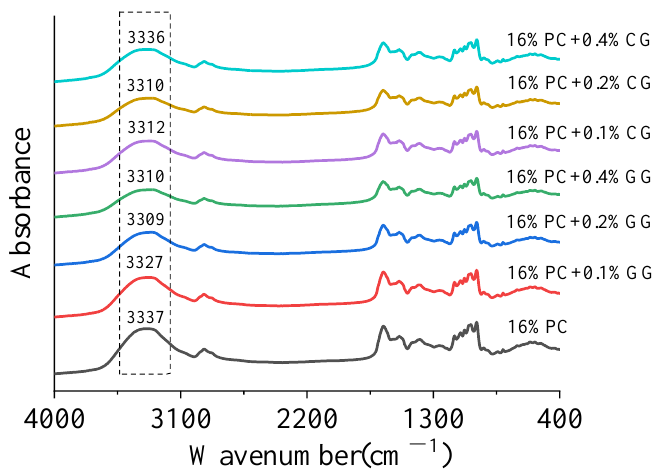
Figure 5. FT-IR spectra of phycocyanin gels with different concentrations of κ -carrageenan/guar gum. Table 3. The secondary structure of phycocyanin gels with different concentrations of κ -carrageenan/guar gum. Polysaccharide Concentrations